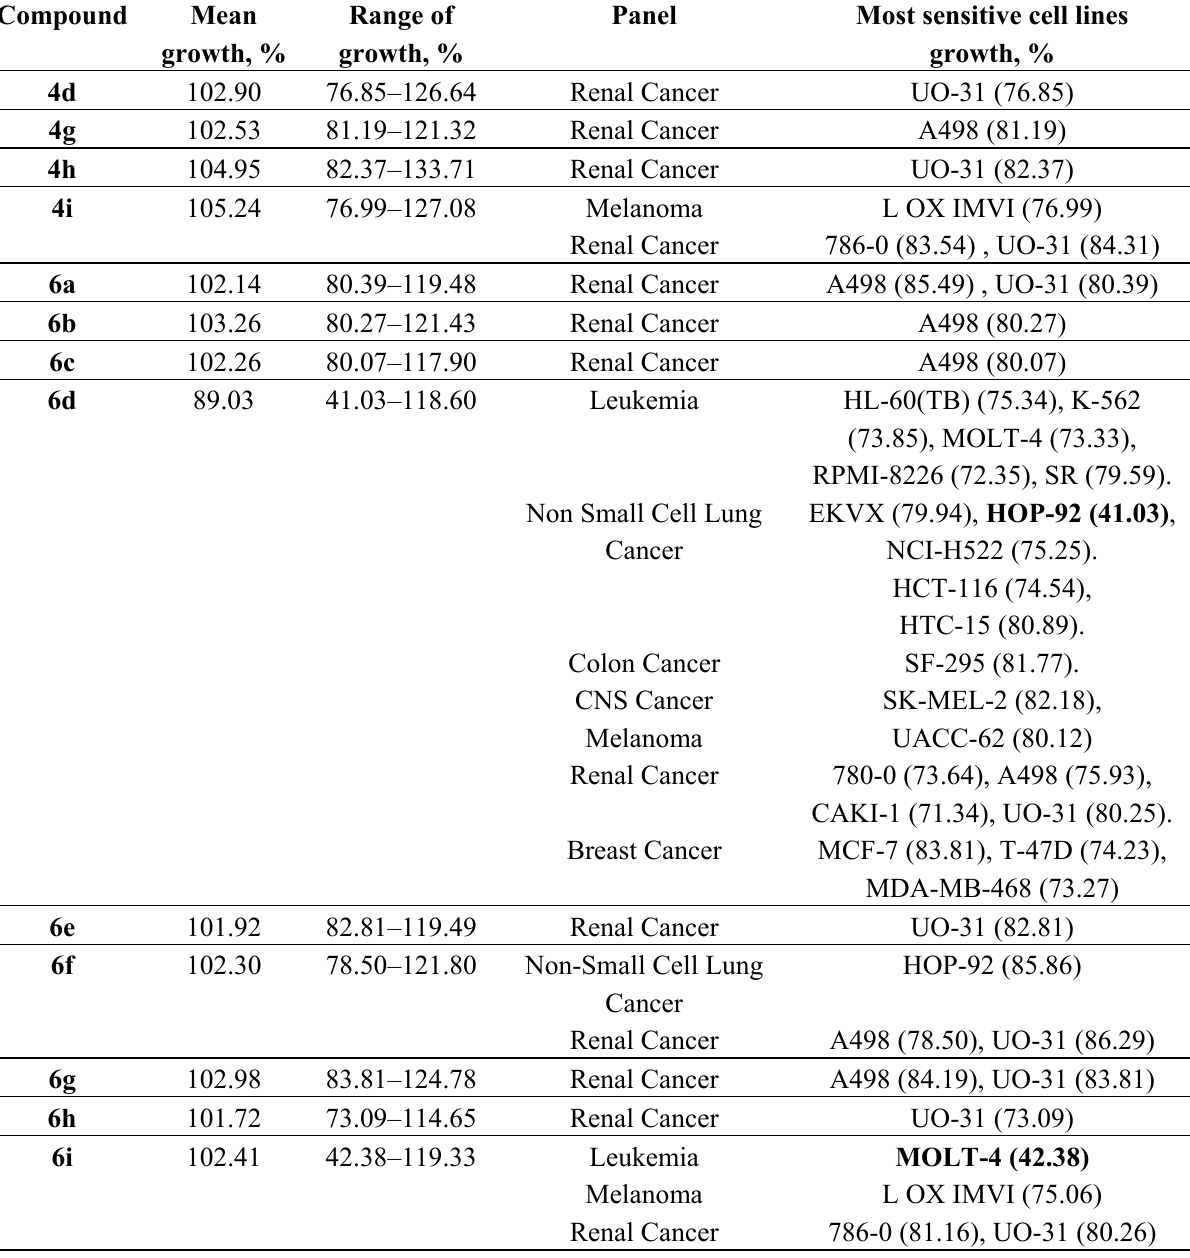
Table 2. Cytotoxic activity of the tested compounds against a panel of 60 cancer cell lines at 10 µM